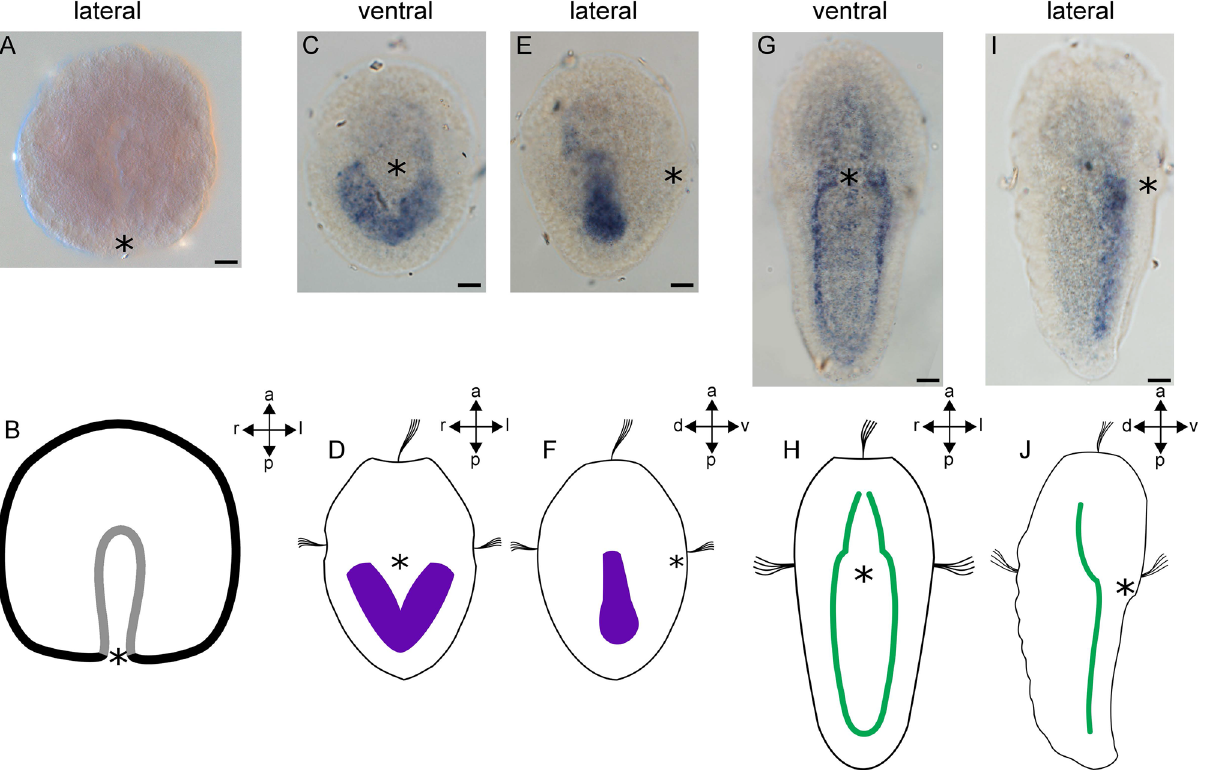
Figure 2. Expression of AfaMox1 during early mesoderm formation in Acanthochitona fascicularis . ( B , D , F , H , J ) are schematic representations of gene expression patterns of the respective developmental stages with gene expression domains indicated in purple and the ventrolateral muscle in green. ( A ) The gastrula is devoid of AfaMox1 expression. ( B ) Lateral right view. ( C – F ) AfaMox1 expression in the early trochophore larva. ( C ) AfaMox1 is expressed in the mesodermal bands. ( D ) Ventral view. ( E ) Lateral right view of AfaMox1 expression in the mesodermal bands. ( F ) Lateral right view. ( G – J ) AfaMox1 expression in the late trochophore larva. ( G ) AfaMox1 expression in the ventrolateral muscle. ( H ) Ventral view. ( I ) Lateral right view of AfaMox1 expression in the ventrolateral muscle. ( J ) Lateral right view. Asterisks mark the blastopore and the mouth, respectively. a anterior, d dorsal, l left, p posterior, r right, v ventral. Scale bar equals 20 µm. Expression pattern schemes were designed with Inkscape (version 0.92.4; https:// inksc ape. org) and Gimp 2 (Version 2.8.22; https:// www. gimp.